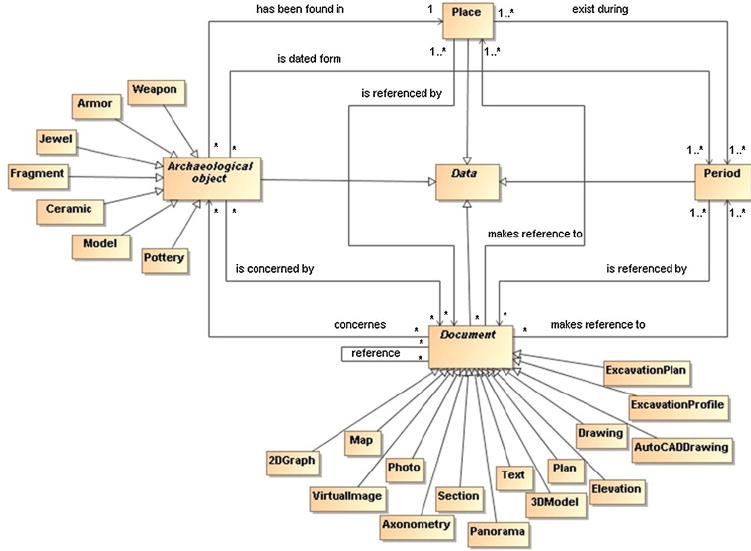
Figure 2. UML class diagram representing the data model of the database (from [47]).